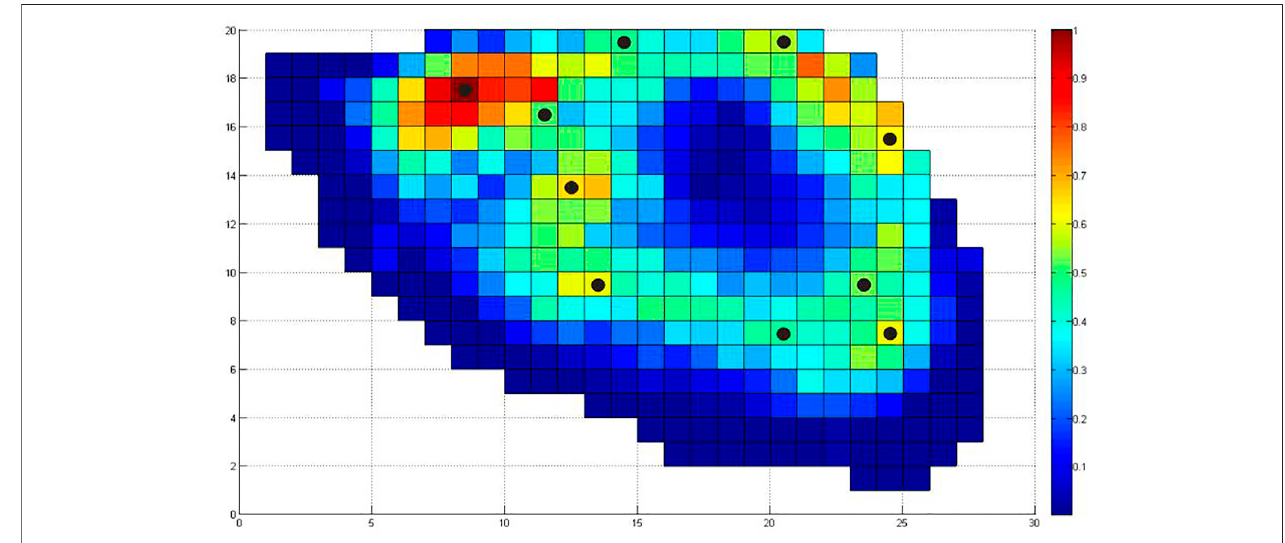
FIGURE 9 | Optimum well placement proposed by the GA + PPMs